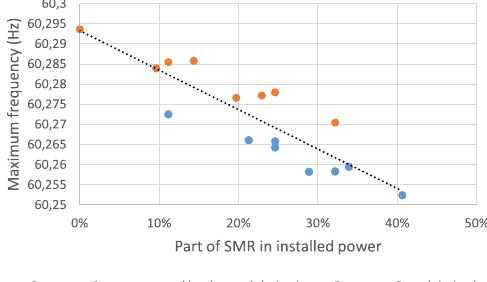
Fig. 14. Evolution of maximum frequency against the part of modularized installed capacity in the grid.